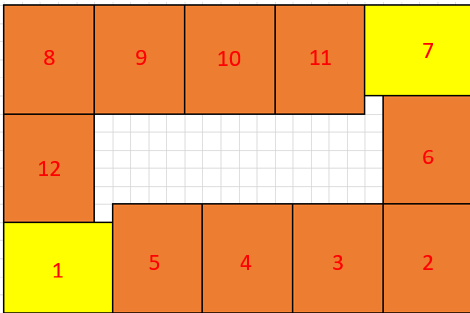
Algorithm 4. Vertical overlap coordinate calculation Figure 19. Vertical overlap object mark. Figure 19. Vertical overlap object